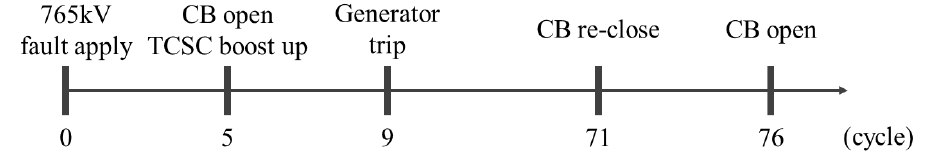
Figure 10. A 345 kV line unbalanced fault is applied at Shin-Jecheon bus; Shin-Jecheon bus voltage (first row) and reactive power of SVC (second row); RTHS (blue line) and large-scale RTS (green line) •